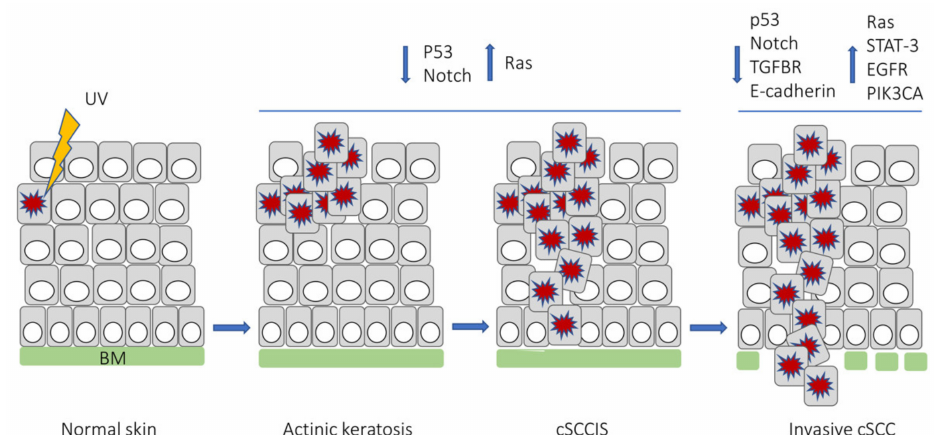
Figure 1. Molecular features involved in the development of actinic keratosis, cutaneous squamous cell carcinoma in situ (cSCCIS), and invasive cSCC. BM, basement membrane; TGFBR, transforming growth factor- β receptor; EGFR, epidermal growth factor receptor; PIK3CA, phosphatidylinositol- 4,5-bisphosphate 3-kinase catalytic subunit α